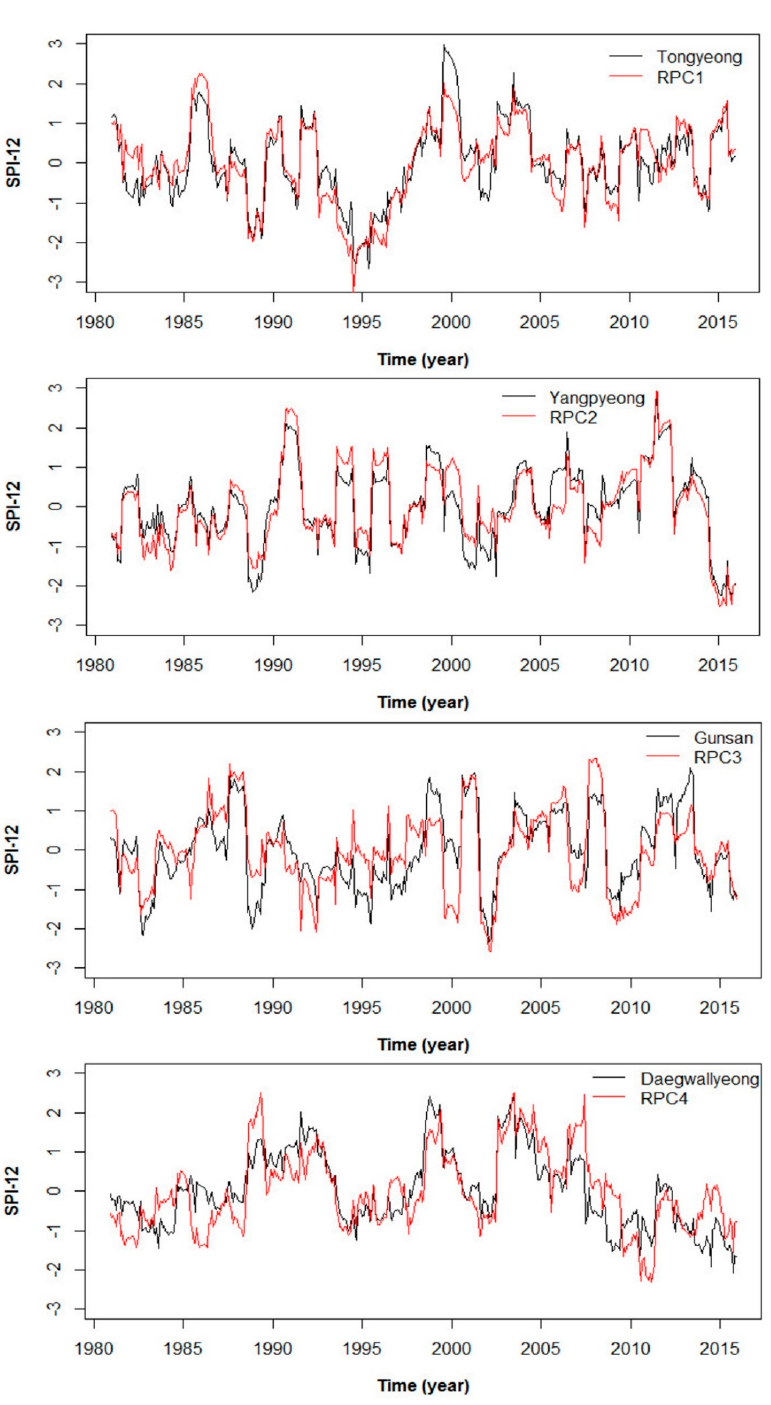
Figure 7. Spatial variability of rotated loading of the leading four principal components based on principal component analysis applied on drought time series.